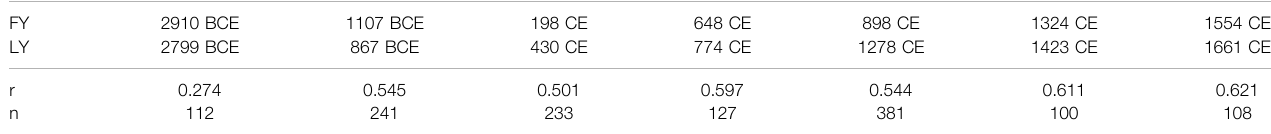
TABLE 3 | Correlations between the tree-ring chronologies based on the minimum blue channel light intensity of subfossil wood (BI) representing the sites at the Arctic timberlineandattheArcticCirclecalculatedoverthewell-replicatedperiods(replication, n ≥ 10seriesperyear).Segmentswithatleast100 yearsofcontinuousdataare shown with their fi rst (FY) and last (LY) calendar years, the Pearson product-moment correlation coef fi cient (r), and the number of years (n) used to calculate the correlation.